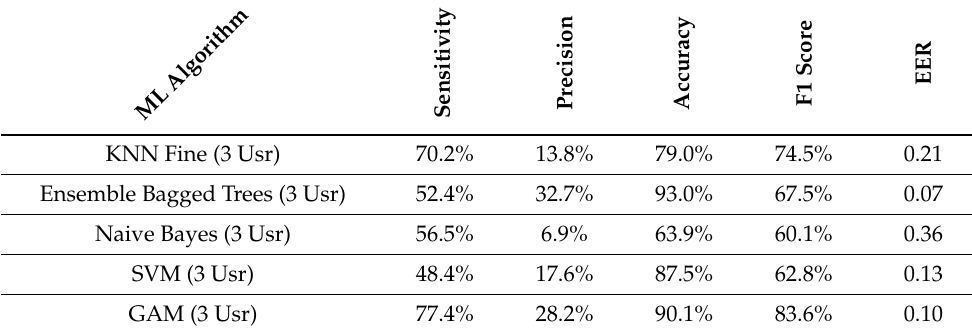
Table 7. PPG Result Details—Multiuser Authentication.